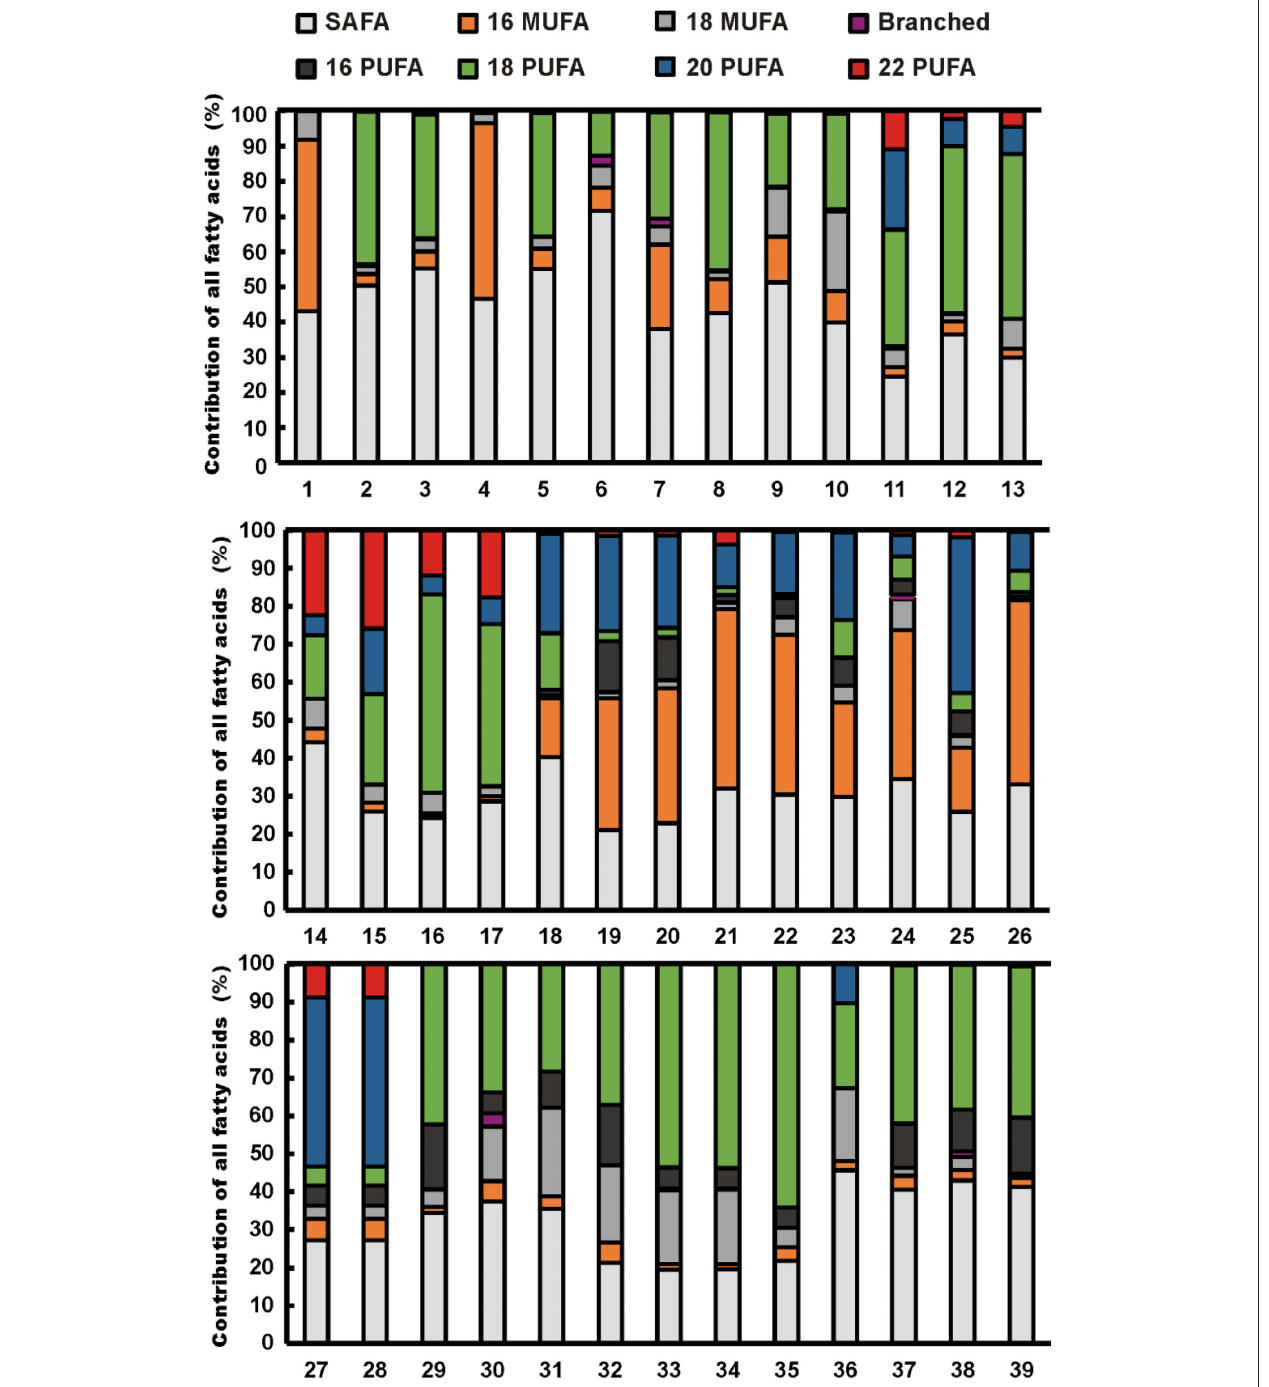
FIGURE 1 | Fatty acid profiles of cultured freshwater phytoplankton strains. Strain numbers are given in Table 2 . Fatty acids are presented as major groups: saturated fatty acids (SAFA), C 16 and C 18 monounsaturated fatty acids (C 16 MUFA, C 18 MUFA), branched fatty acids, and C 16 , C 18 , C 20 , and C 22 polyunsaturated fatty acids